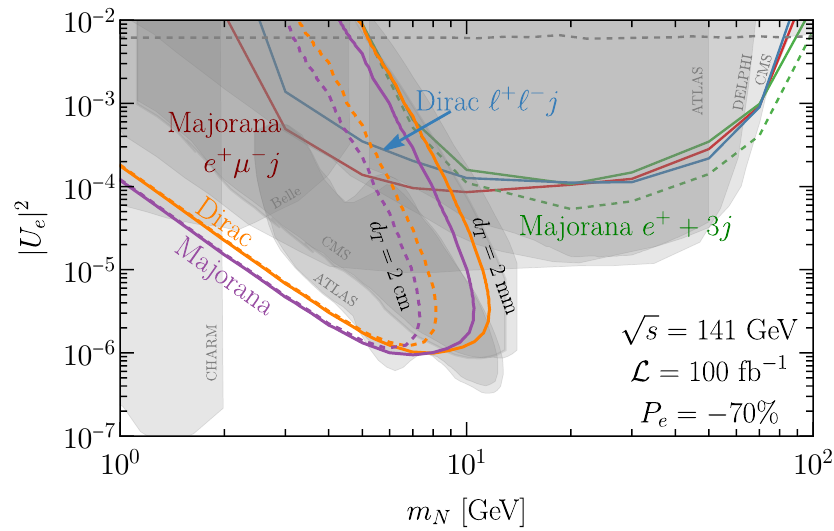
Figure 15 . The combined EIC sensitivity to HNL, compared with the existing bounds [74–81]. For details, we refer the reader to figures 9 and